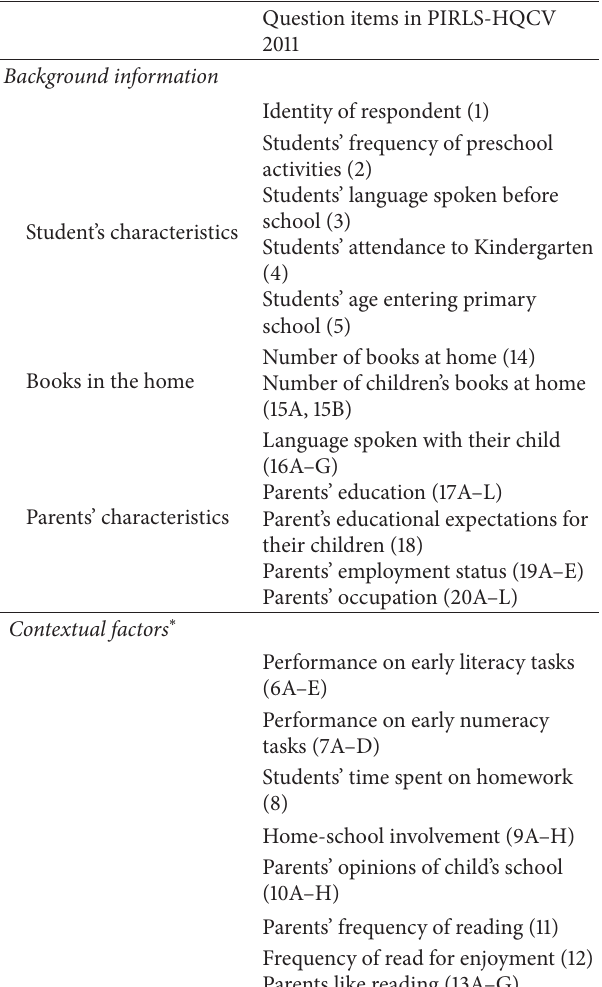
Table 1: Content of the PIRLS 2011 home questionnaire (PIRLS- HQCV